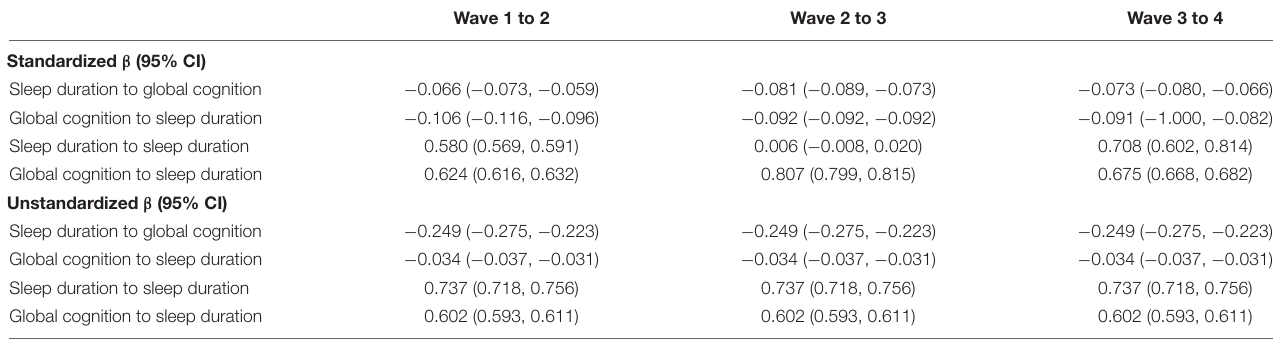
TABLE 3 | Cross-lagged models across all four waves*. Wave 1 to 2 Wave 2 to 3 Wave 3 to